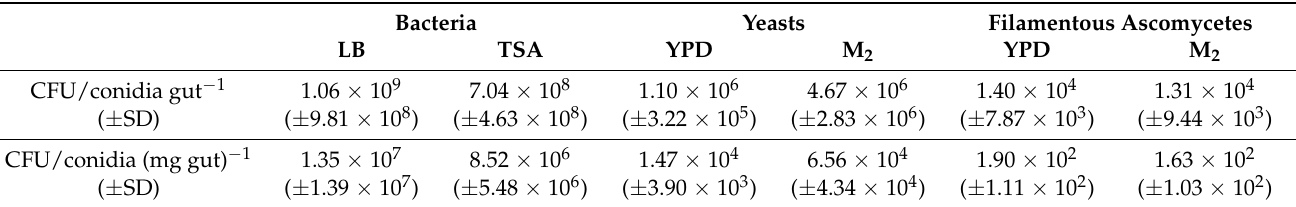
Table 1. Calculation of the bacterial and yeast CFU as well as the ascomycete conidia. Values represent the mean of 16 larval guts ( ±